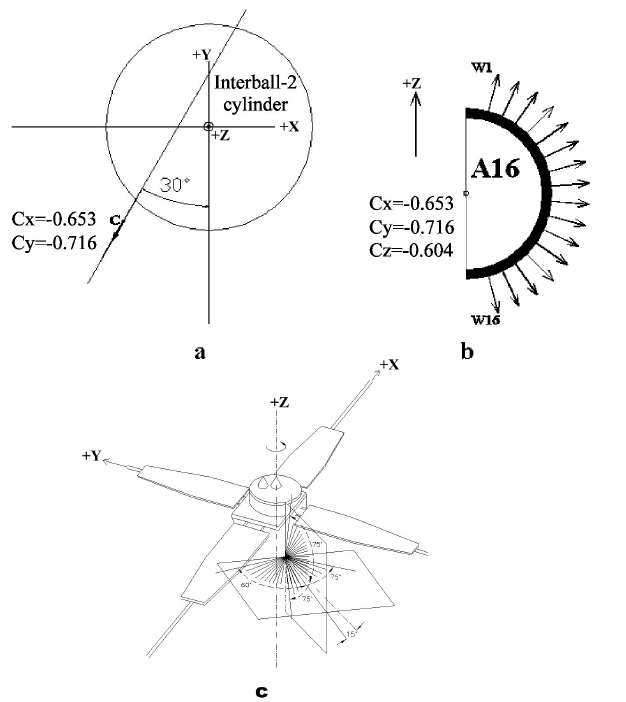
Fig. 1. Position and pointing directions of the Hyperboloid A16 analyser: (a) trace of the detector plane on the XY plane and A16 center position ( C x ,C y ,C z ), (b) cut showing pointing directions in the A16 detector plane, and (c) global view showing the geometry of the two analyzers relative to the satellite body.